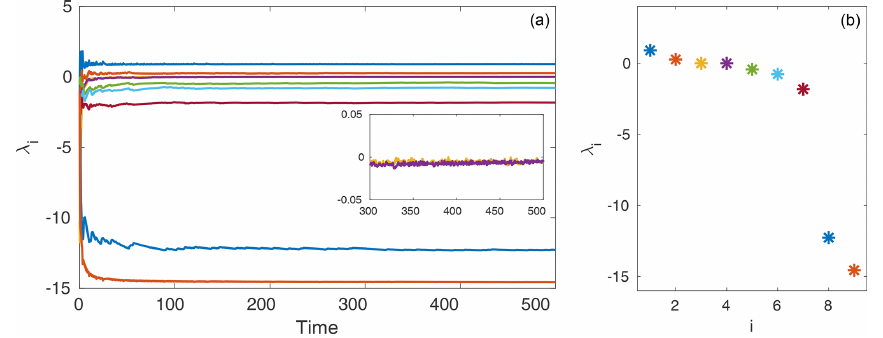
Figure 3. (a) Convergence of Lyapunov exponents of Eq. (1) with an inset of zoom around zero to show the two neutral exponents. (b) Asymptotic values of Lyapunov exponents of Eq. (1). Table 1. Asymptotic Lyapunov exponents of Eq. (1) computed over 500 time units using a QR decomposition method, time step of 0.01, and orthogonalization step of 0.25. λ 1 λ 2 λ 3 λ 4 λ 5 λ 6 λ 7 λ 8 λ 9 0.9071 0.2670 − 0 . 0056 − 0 . 0060 − 0 . 4326 − 0 . 7706 − 1 . 8263 − 12 . 2691 − 14 .